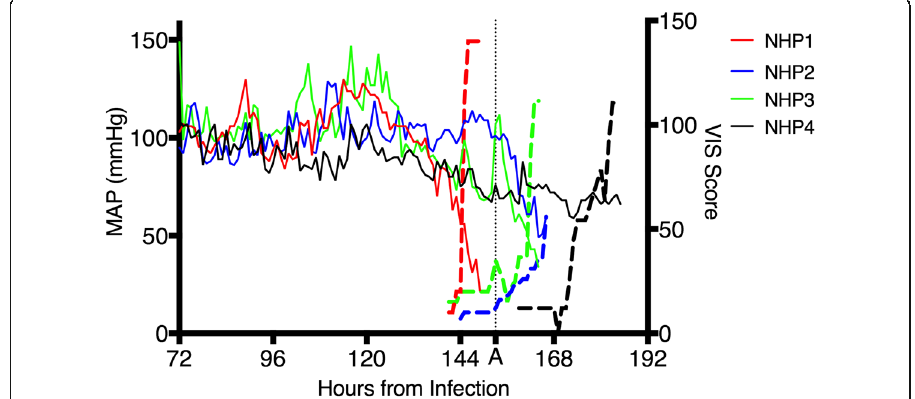
Fig. 2 Effect of vasoactive medications on mean arterial pressure. Mean arterial pressure (solid colored lines plotted on the left Y -axis) compared to the VIS score (dashed lines plotted on the right Y -axis). The vertical dashed line labeled “ A ” denotes the start of vasopressin for NHP3. Note that the X -axis was truncated